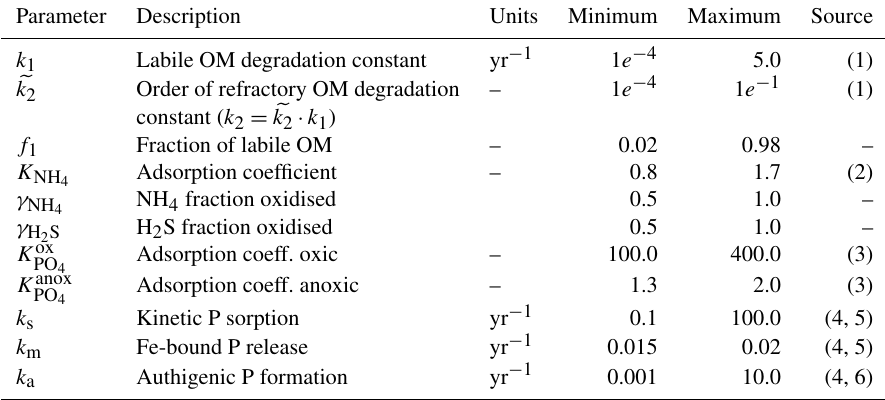
Table 11. Range of model parameters used for the sensitivity analysis of model-predicted output. Parameter